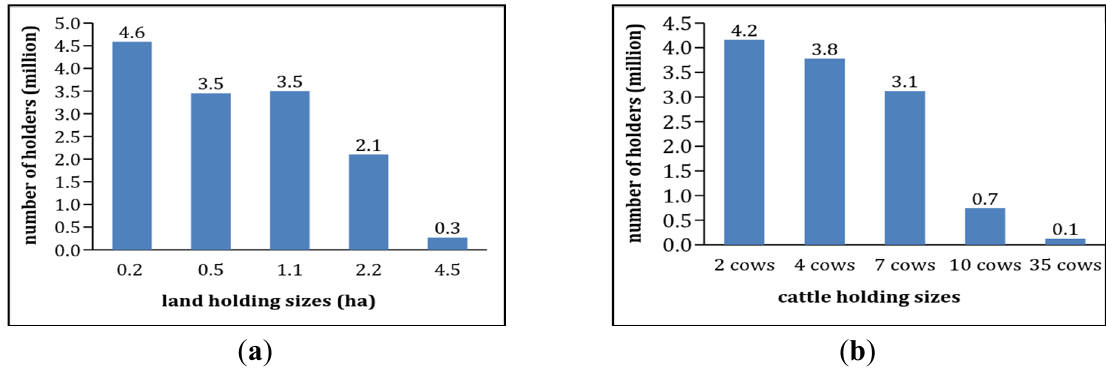
Figure 1. Households biomass resources holding sizes based on data from [25]. ( a ) Land holding; ( b ) Cattle holding; households are grouped based on the average size of